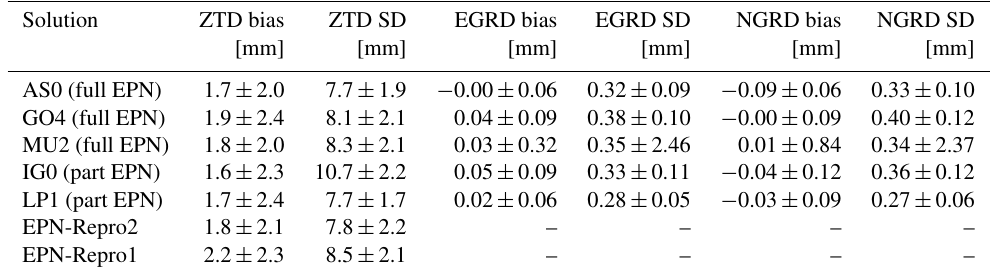
Table 4. Mean statistics and uncertainties, calculated from results of individual stations, provided for AC individuals and EUREF combined (EPN-Repro1 and EPN-Repro2) tropospheric parameters compared to the ERA-Interim reanalysis (ERA-Interim minus GNSS). EGRD represents east gradient and NGRD north